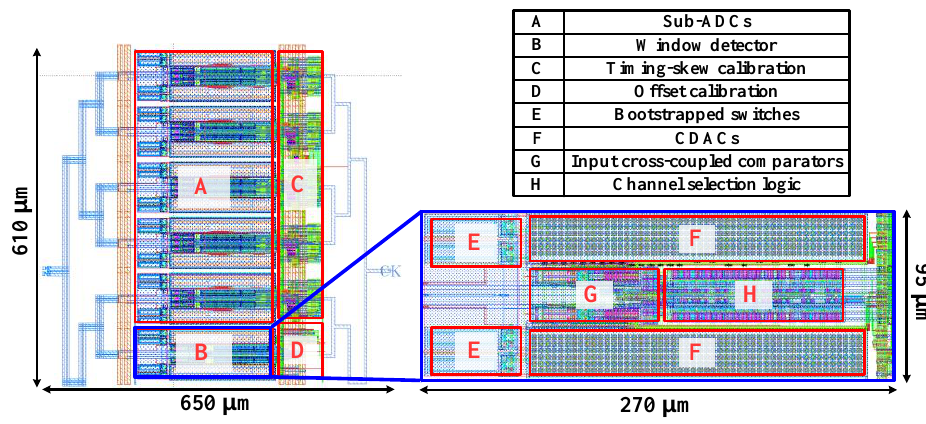
Figure 15. Top layout of the proposed time-interleaved SAR ADC.